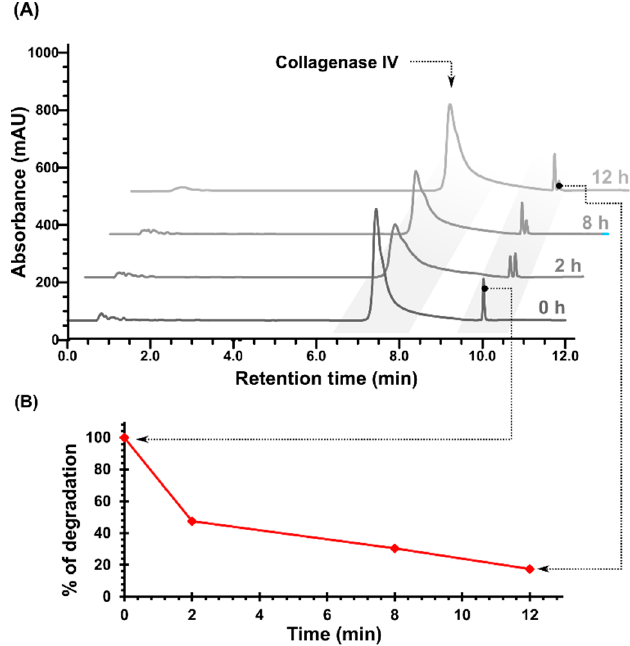
Figure 2. ( A ) HPLC chromatograms of the MMP-2/-9-cleavable peptide after 2, 8, and 12 h of incubation with collagenase IV. ( B ) The curves depicting the efficacy of enzymatic cleavage, triggered in a time-dependent manner.